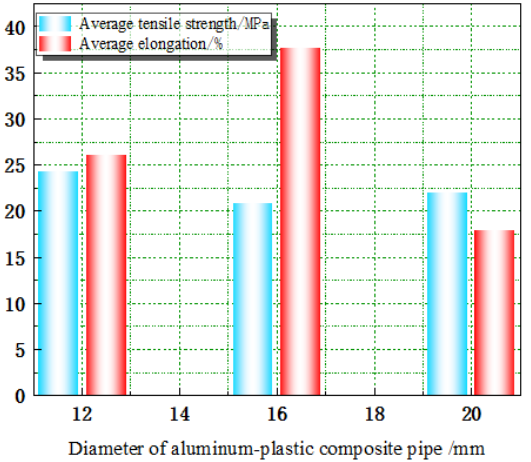
Figure 4. Tensile strength of aluminum–plastic composite pipes.